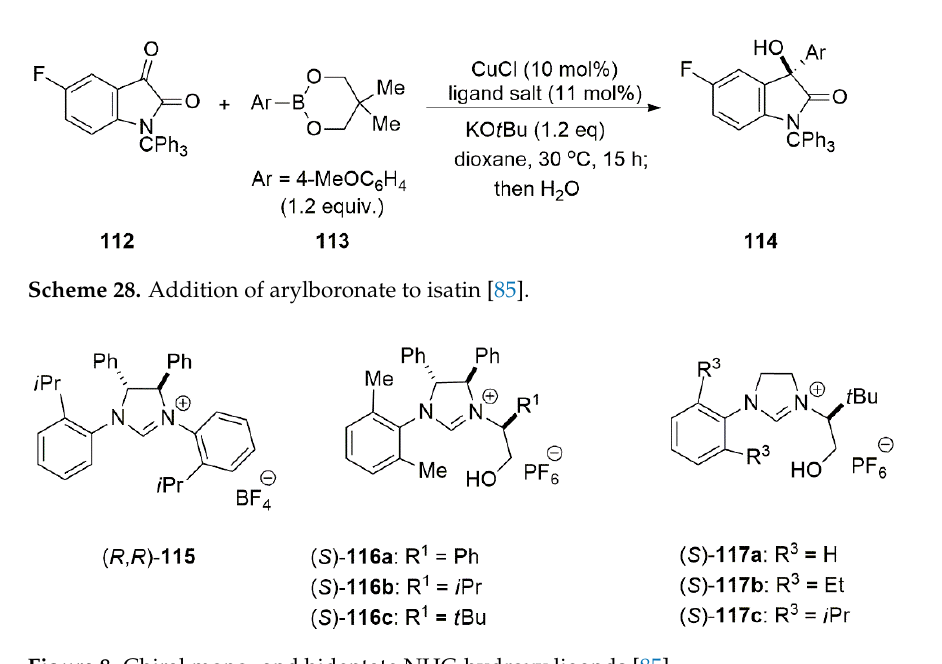
Figure 9. Chiral bidentate NHC ‐ hydroxy ligands [154].